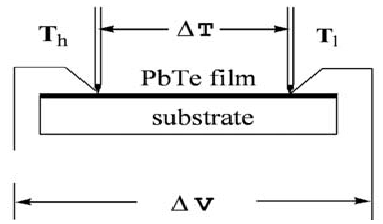
Figure 11. Schematic diagram of the Seebeck coefficient measurement.